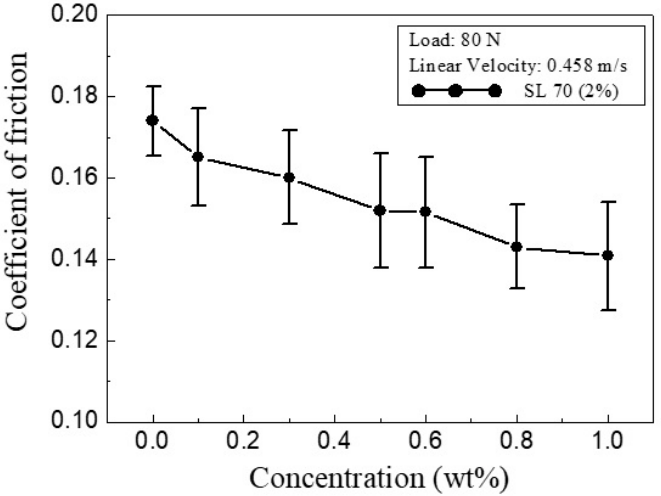
Figure 5. Coe ffi cient of friction (COF) variation of di ff erent CNC concentrations in water working fluid. Figure 5. Coefficient of friction (COF) variation of different CNC concentrations in water working fluid.